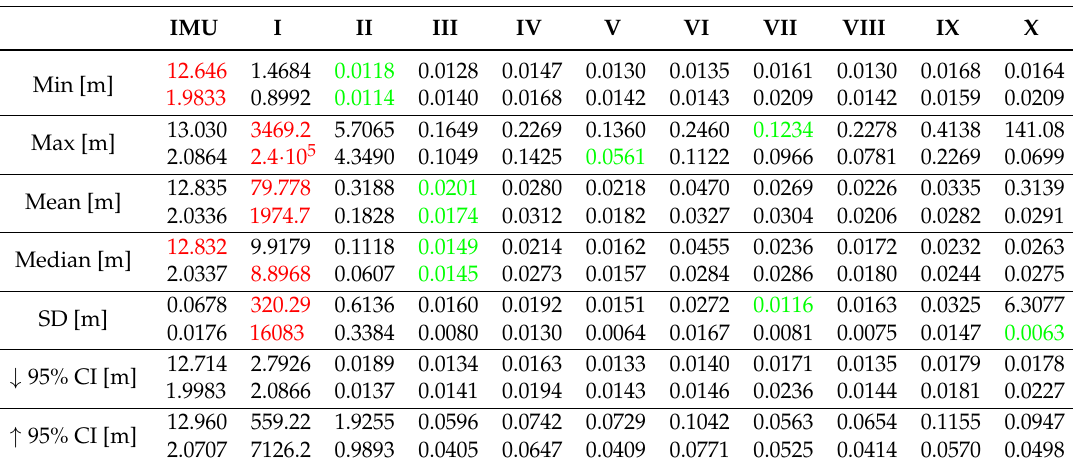
Table 4. Root mean square error (RMSE) for position by means of 500 replications. The Roman numerals refer to respective state constraints applied regarding Table 3. Each of the seven characteristic values (minimum, maximum, mean, median, standard deviation (SD) as well as lower bound ( ↓ ) and upper bound ( ↑ ) of the 95% confidence interval (CI)) are divided into two additional rows regarding moderate (above) and accurate (below) inertial measurement unit (IMU). The largest (red) and lowest (green) estimates are marked for first five